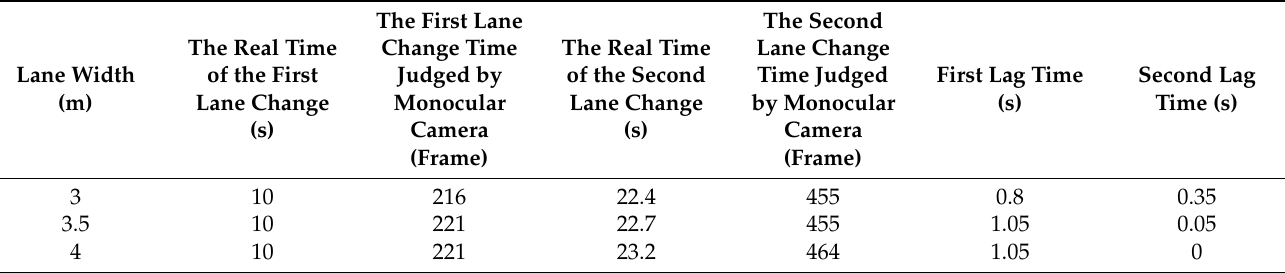
Figure 19. Lane changing judgment of monocular camera with different lane widths. Table 4. Lag time for different lane widths.